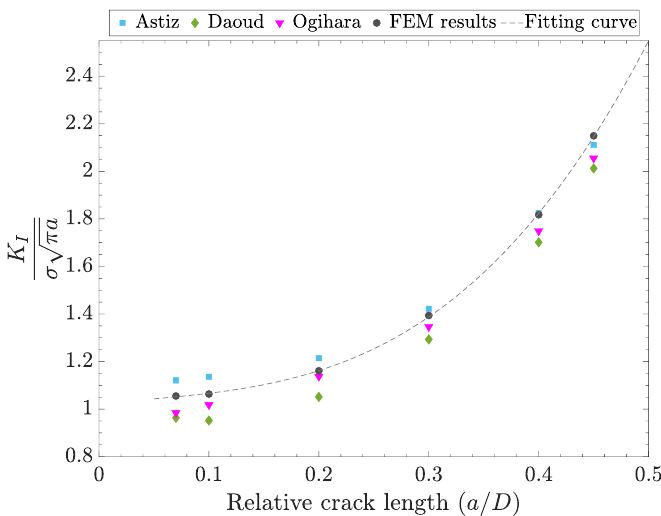
Figure A1. Comparison of the non-dimensional stress intensity factor of an isotropic free fibre subjected to uniform tension obtained in this work (FEM), with Astiz [26], Daoud et al. [6], and Ogihara et al. [4].